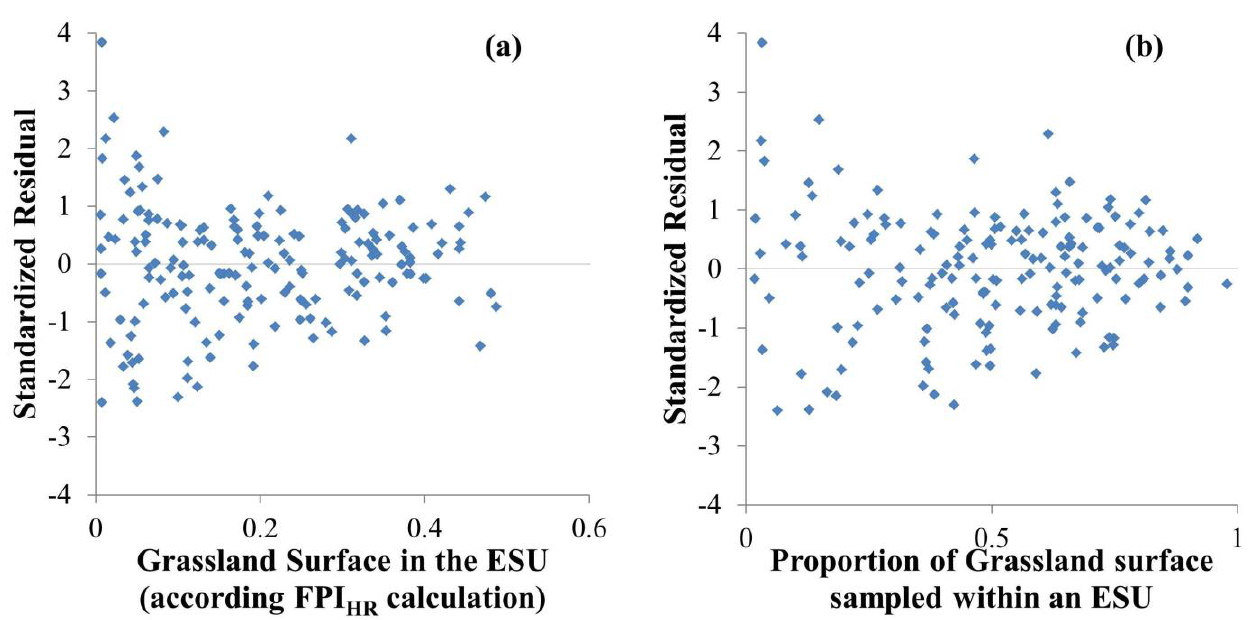
Figure 10. Standardized residuals of the linear regression for 2014 between FPI MR and FPI HR according to ( a ) the percentage of grassland surface in the ESU (for 173 ESUs of 3600 ha). ( b ) The percentage of grassland sampled to build the FPI HR in the ESU (for 173 ESUs of 3600